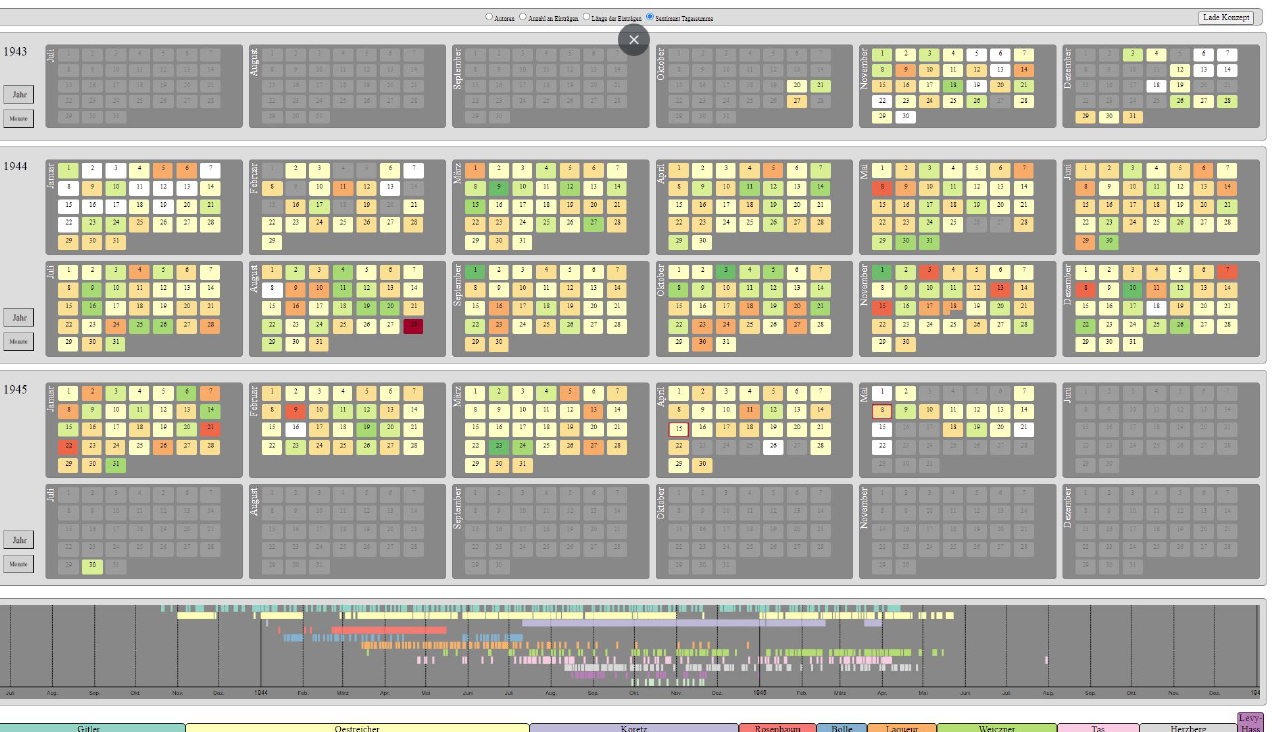
Figure 14. Mode to add all the sentiments (which are between − 1 for fully negative and +1 for fully